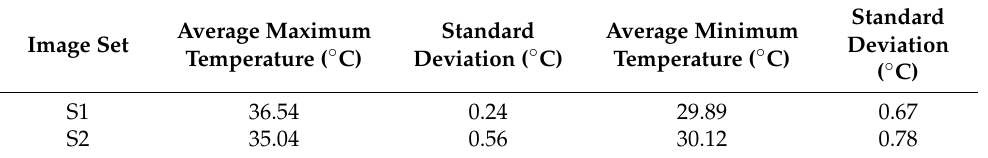
Table 10. Average maximum and minimum temperatures for image sets S1 and S2. The temperature standard deviations were not higher than one degree, which can be acceptable to be considered as stable information concerning the passive thermography technique.